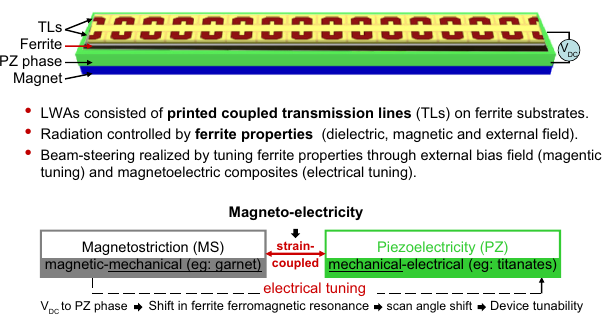
Figure 9. Layout of the magnetoelectic LWA comprised of ferrite, piezoelectric phase and magnets for electronic scanning.